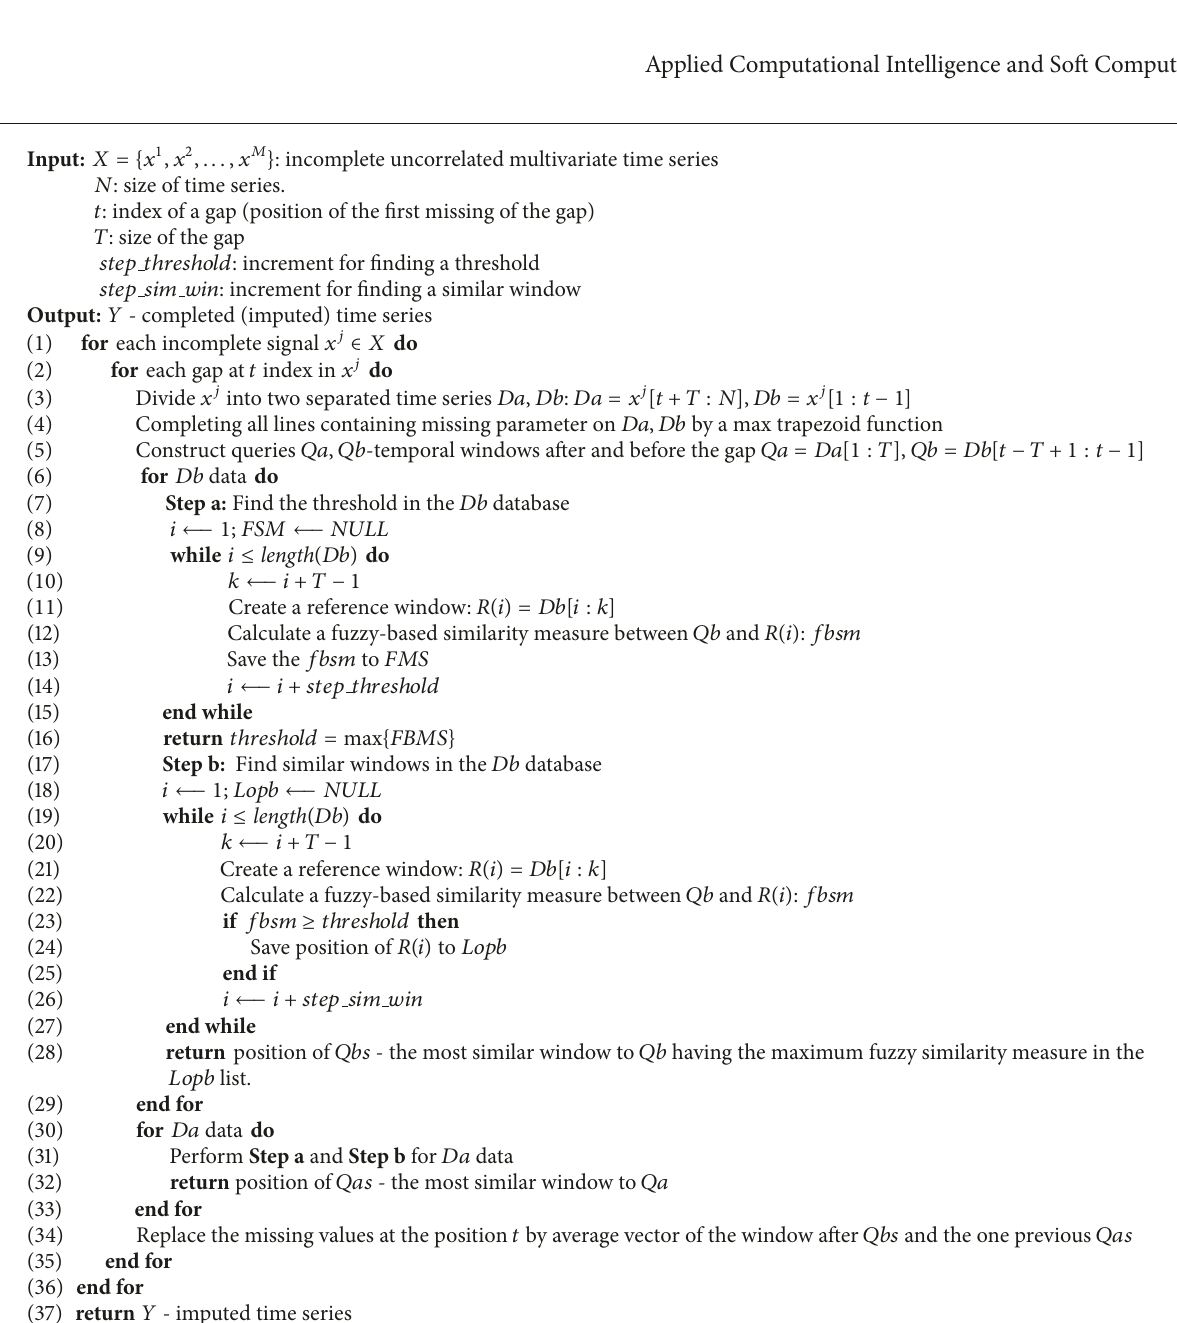
Algorithm 1: FSMUMI